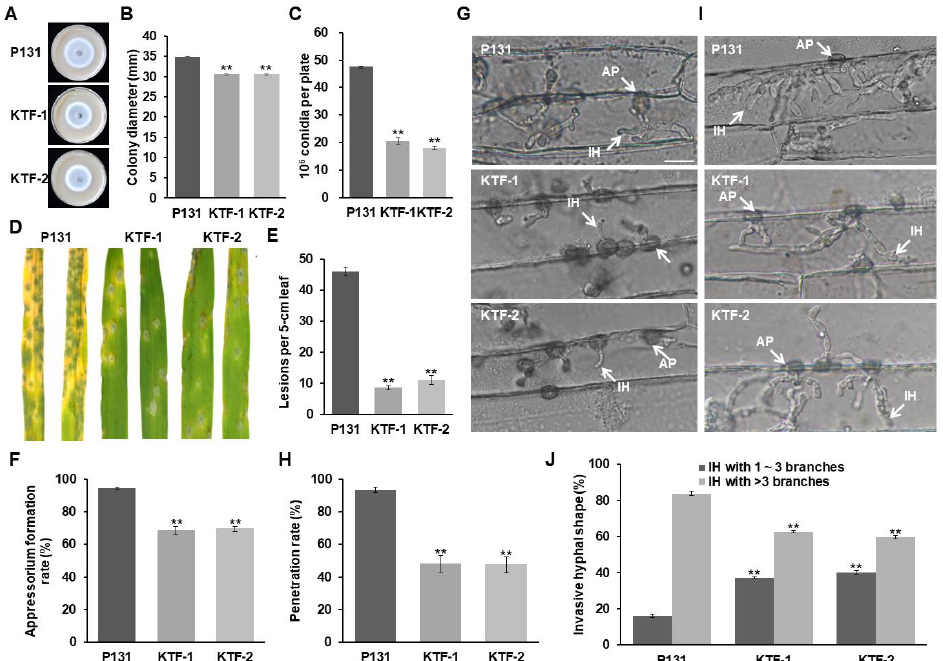
Figure 7. MoTAF14 is also required for fungal virulence and development. ( A ) Colonies of the wild-type P131, and the ∆ MoTaf14 mutants KTF − 1 and KTF − 2 cultured on OTA plates at 5 dpi. ( B ) Statistics on colony diameters of strains P131, KTF − 1, and KTF − 2 at 5 dpi. The mean and standard deviations were calculated based on three independent experiments by measuring three plates in each replicate. Asterisk marks a significant difference between the mutants from strain P131 by using t -test ( p < 0.05). ( C ) Capacity on conidiation of strains P131, KTF − 1, and KTF − 2. The mean and standard deviations were calculated based on three independent experiments by measuring three plates in each replicate. Asterisk marks a significant difference between the mutants and the P131 strain by using t -test ( p < 0.05). ( D ) Barley seedlings sprayed with conidia of strains P131, KTF − 1, and KTF − 2. Typical diseased leaves were photographed at 5 dpi. ( E ) Bar graphs showing the number of disease lesions on 5 cm rice leaf infected by strains P131, KTF − 1, and KTF − 2. The mean and standard deviations were calculated based on three independent experiments by measuring 10 diseased leaves in each replicate. Asterisk marks a significant difference between the mutants and the P131 strain by using t -test ( p < 0.05). ( F ) Percentages of appressorium formation of strains P131, KTF − 1, and KTF − 2 on cover glass slides at 12 hpi. The mean and standard deviations were calculated based on three independent experiments by measuring 100 germinated conidia in each replicate. Asterisk marks a significant difference between the mutants and the P131 strain by using t -test ( p < 0.05). ( G ) Appressorial penetration of strains P131, KTF − 1, and KTF − 2 on barley leaves at 24 hpi. AP, appressoria; IH, invasive hyphae. Bar, 20 µ m. ( H ) Percentages of appressorial penetration of strains P131, KTF − 1, and KTF − 2 on barley leaves at 24 hpi. The mean and standard deviations were calculated based on three independent experiments by measuring 100 appressoria in each replicate. Asterisk marks a significant difference between the mutants and the P131 strain by using t -test ( p < 0.05). ( I ) Invasive hyphae of strains P131, KTF − 1, and KTF − 2 on barley leaves at 36 hpi. AP, appressoria; IH, invasive hyphae. Bar, 20 µ m. ( J ) Percentages of invasive hyphae of strains P131, KTF − 1, and KTF − 2 on barley leaves at 36 hpi. The invasive hyphae were classified into two main types, 1–3 branches and more than 3 branches. The mean and standard deviations were calculated based on three independent experiments by measuring 100 invasive hyphae in each replicate. Asterisk marks a significant difference between the mutants and the P131 strain by using t -test ( p <